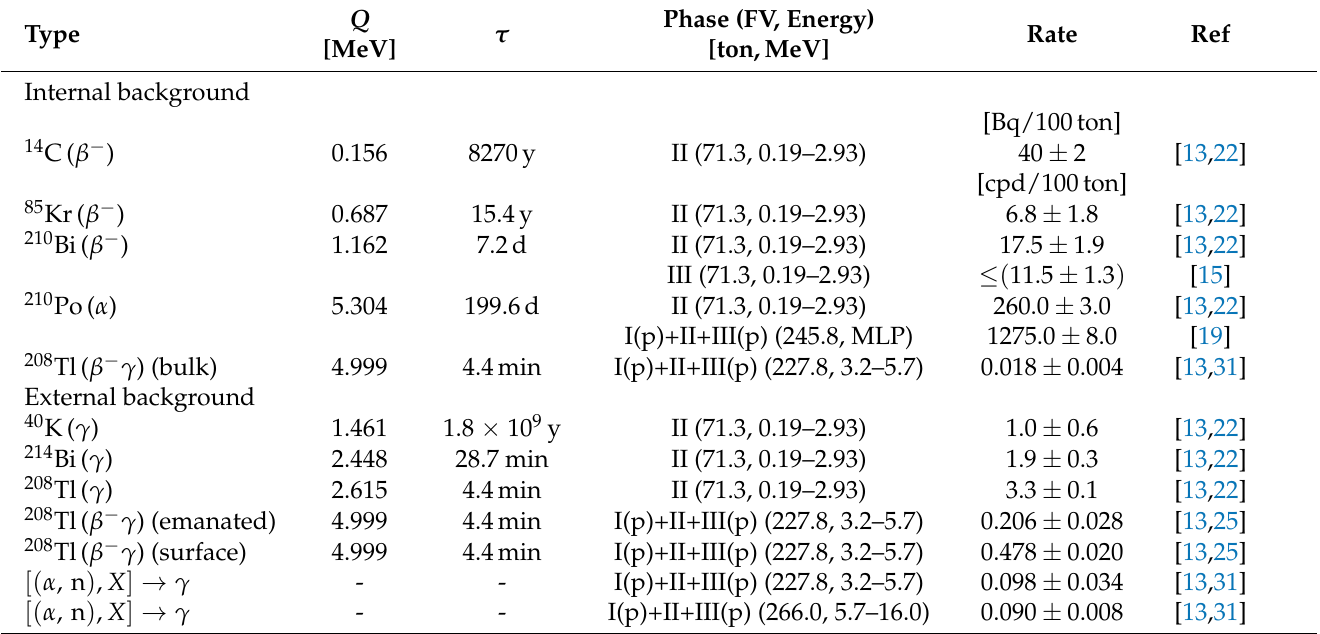
Table 1. Summary of the internal and external backgrounds in Borexino. The columns (from left to right) specify the isotope and its decay type, Q value, lifetime, details of the analysis (data-taking phase, where the abbreviation p indicates that only a part of the corresponding phase was considered (see also Table 4), fiducial mas, and energy range) where the background was relevant, the estimated rate, and the corresponding reference. The MLP in the fourth column stands for 210 Po events, which have been selected with the MLP variable (see Section 2.2). The rates for the internal backgrounds are given for zero threshold, while the rates of the external backgrounds are given for the energy range of the analysis. The rates of the external backgrounds do not scale linearly with the volume and were normalized to 100ton just for the sake of comparison.